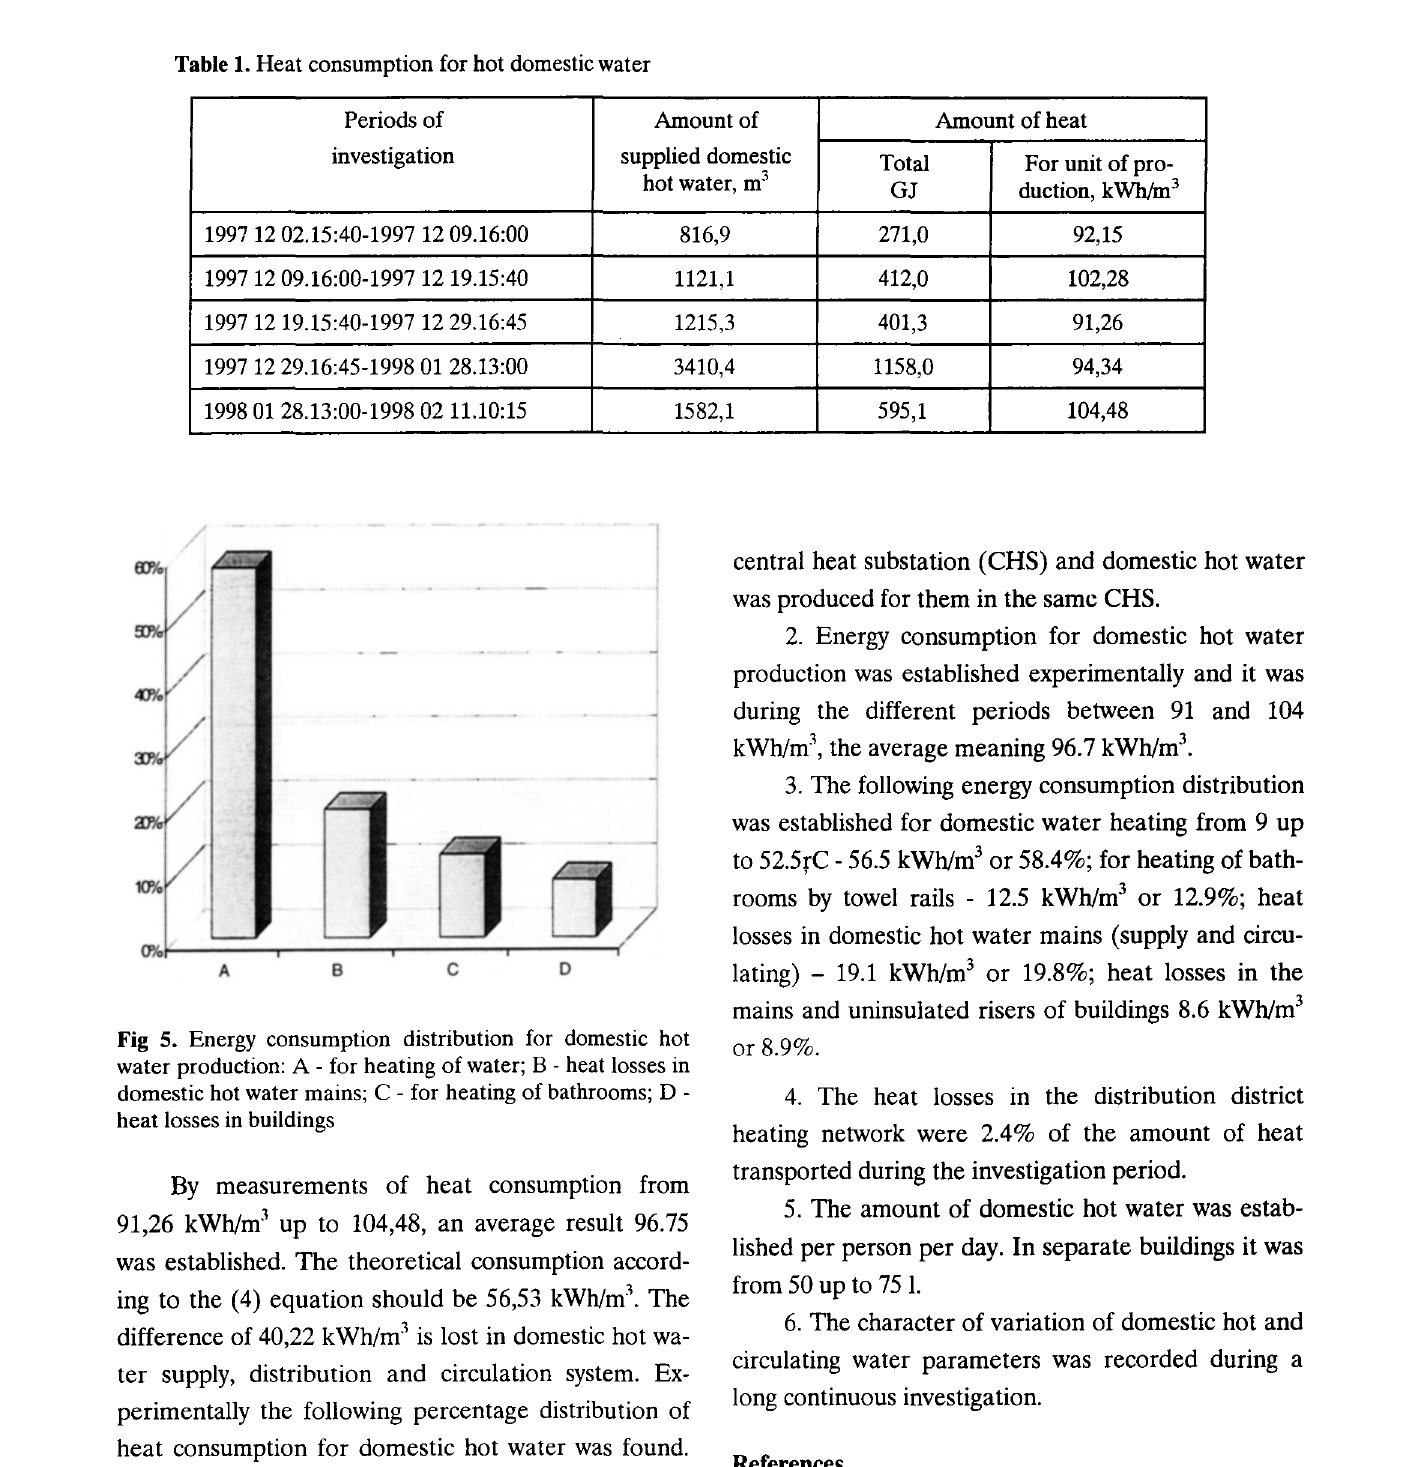
Table 1. Heat consumption for hot domestic water